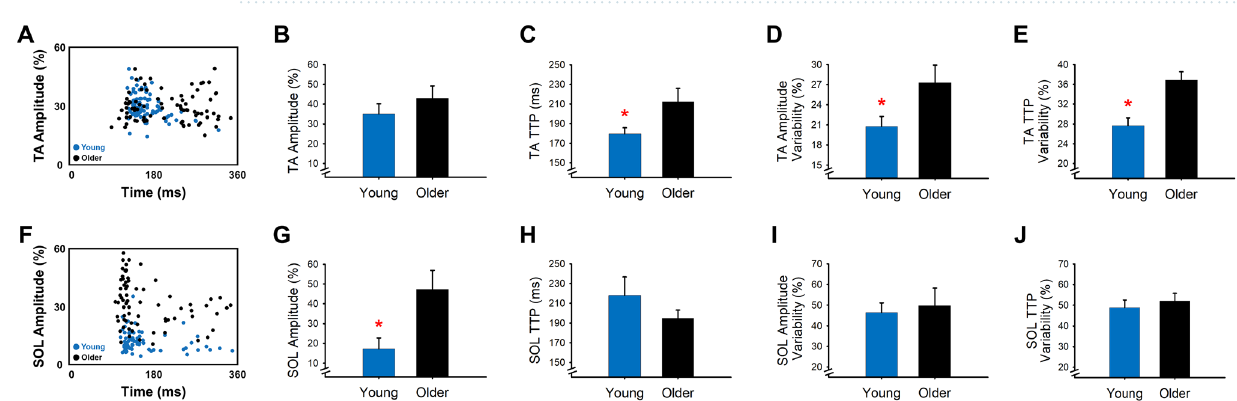
Figure 4. Age-associated differences in muscle activation. Representative example of TA muscle activity ( A ) and SOL muscle activity ( F ) for a young and an older adult. Relative to young adults, older adults had similar normalized TA amplitude ( B ) but greater TA time-to-peak (TTP; C ), TA amplitude variability ( D ), and TA time-to-peak variability ( E ). Furthermore, older adults exhibited greater normalized SOL amplitude ( G ) but similar SOL time-to-peak ( H ), SOL amplitude variability ( I ), and SOL time-to-peak variability ( J ). *p <